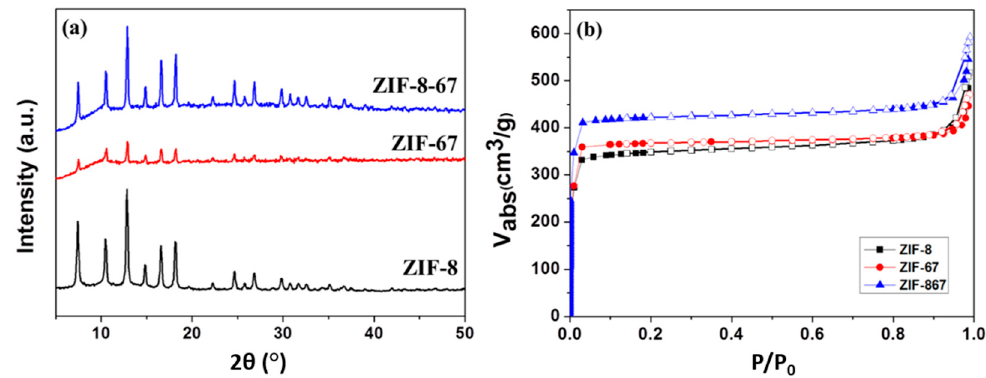
Figure 1. ( a ) XRD patterns of ZIF-8, ZIF-67, and ZIF-8-67 samples; ( b ) comparison of N 2 adsorption/ desorption isotherms of ZIF-8, ZIF-67, and ZIF-8-67 samples.